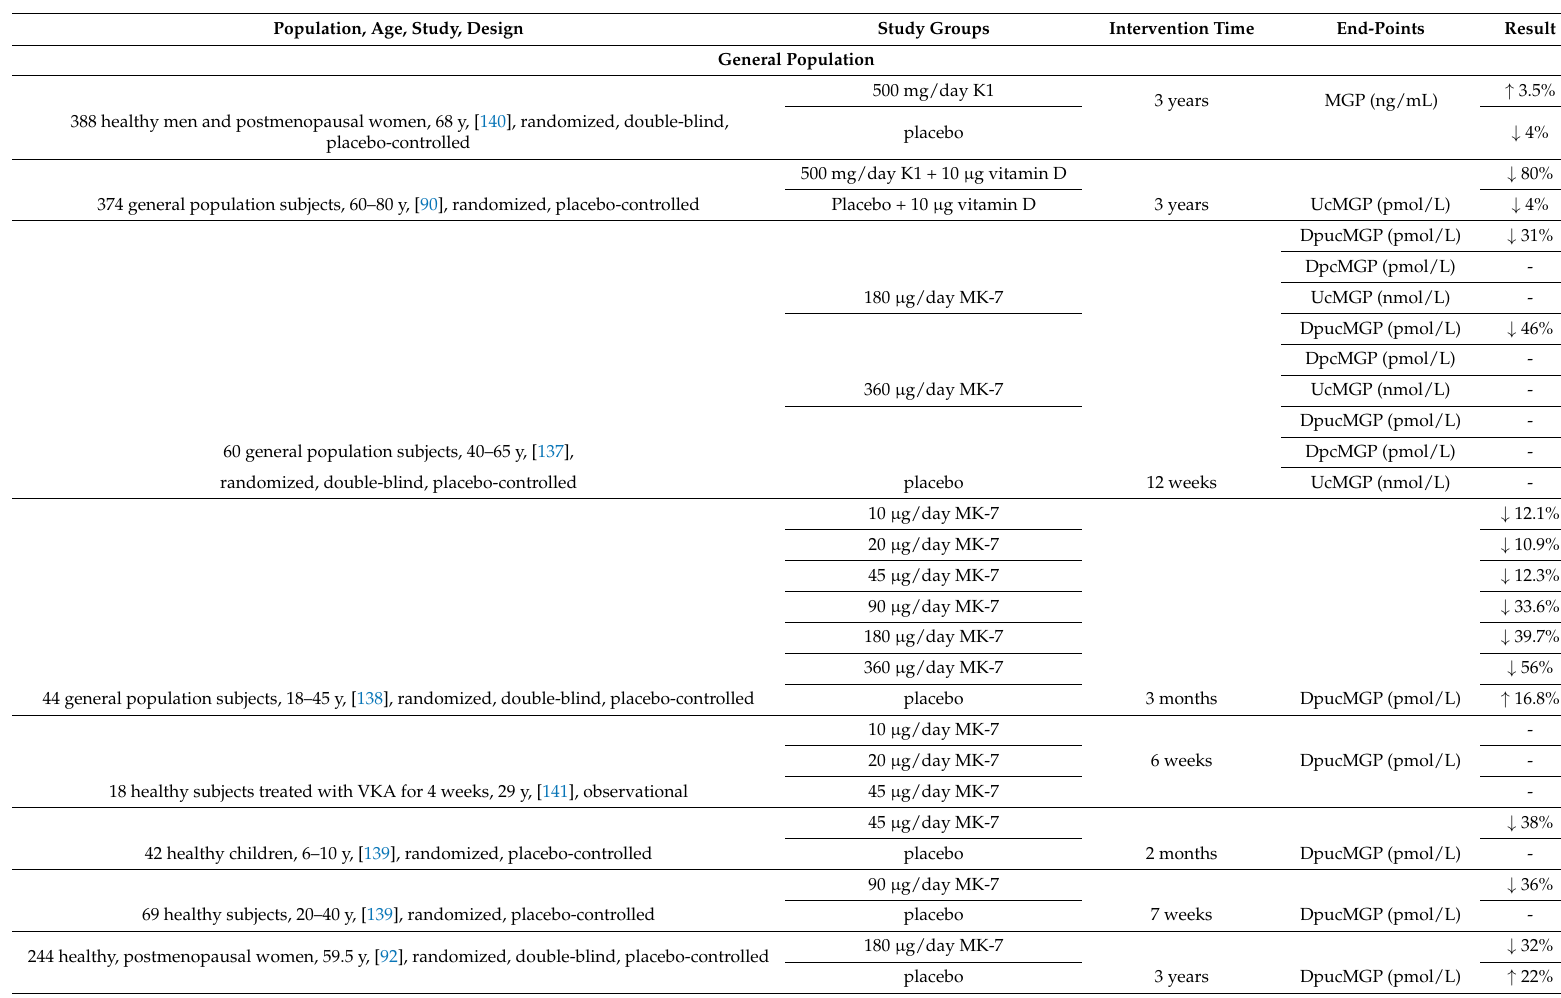
Table 3. Overview of vitamin K effects on circulating levels of MGP